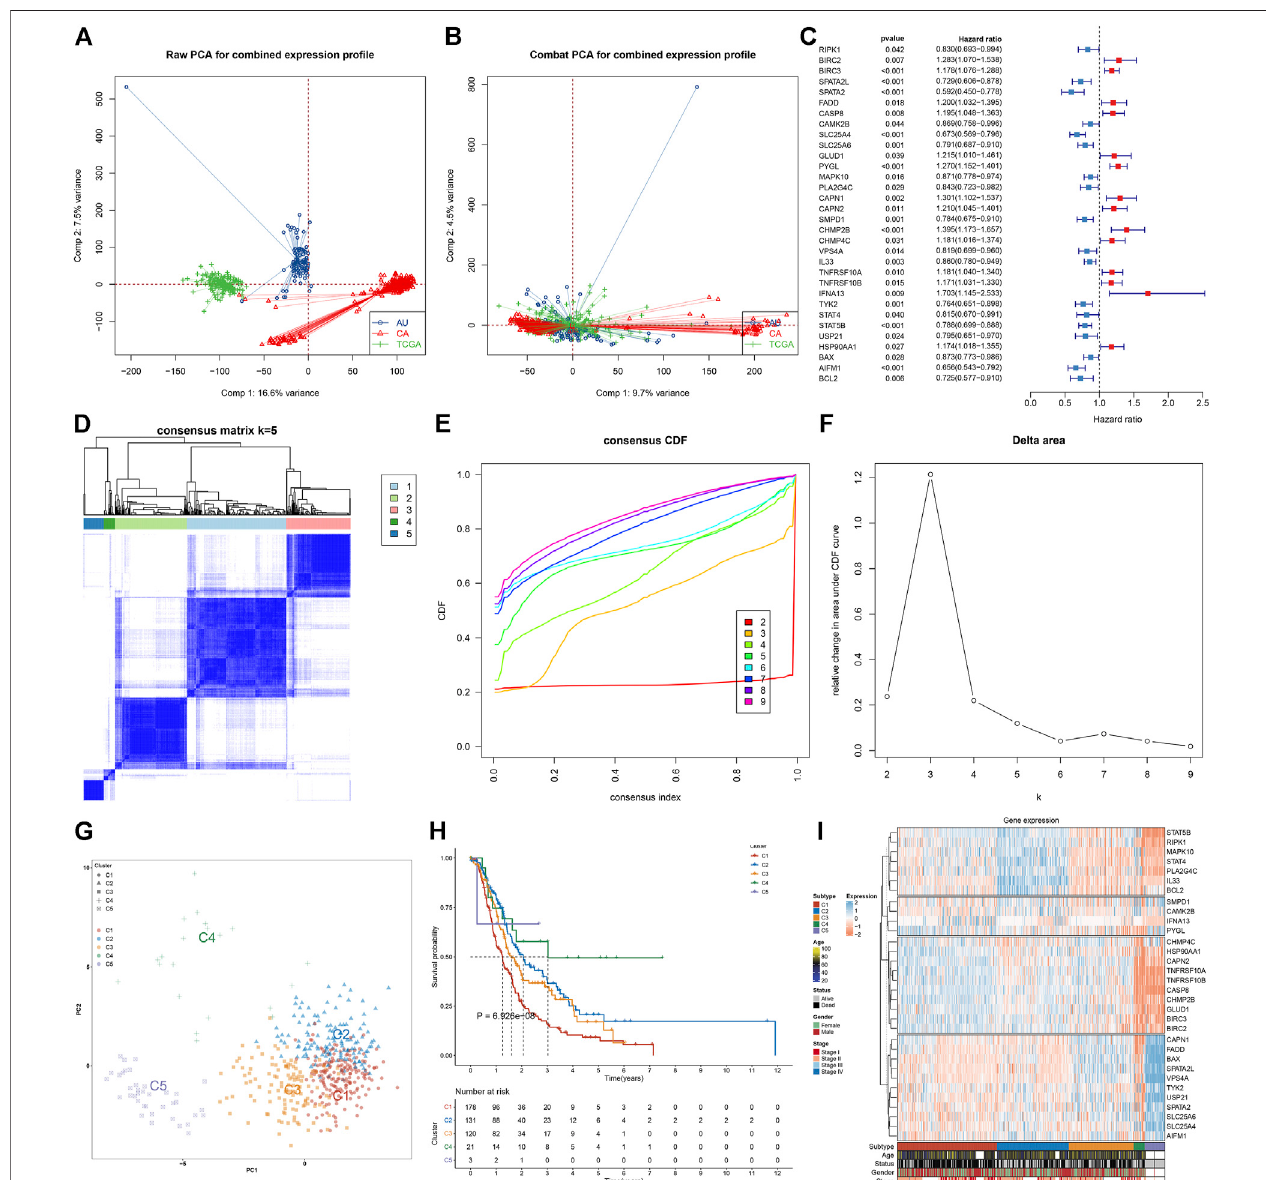
FIGURE 1 | Characterization of fi ve necroptosis subtypes with diverse survival outcomes for pancreatic cancer in the integrated TCGA, PACA-AU, and PACA-CA cohorts. (A,B) PCA plots show the data before and after the removal of the batch effects. (C) Forest plots visualize the hazard ratios and p-values of prognostic necroptosis genes for pancreatic cancer patients utilizing univariate Cox regression models. Red, risk factor; blue, protective factor. (D) Based on the expression values of prognostic necroptosis genes,the consensus matrixisshown when k =5. The rowsand columns ofthe matrixrepresentsamples. Thevaluesofthe consensus matrixrangefrom 0(cannot beclustered) to1(alwaysclustered) inwhitetodark blue. (E) Consensus CDF plotwhen k=2 – 9. (F) Deltaareaplotwhen k =2 – 9.Thedelta areascore( y -axis)indicatestherelativechangeinclusterstability. (G) PCAplotsvisualizethedifferenceamong fi venecroptosissubtypes,followingtheexpressionvalues of prognostic necroptosis genes across pancreatic cancer specimens. (H) Survival analysis of fi ve necroptosis subtypes. (I) Heatmap visualizes the expression of prognostic necroptosis genes in diverse necroptosis subtypes.